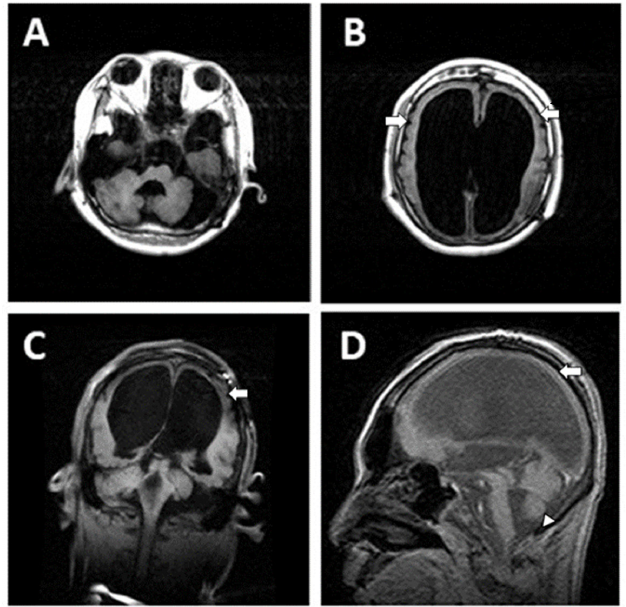
Figure 2. Brain MRI (T1WI) of Case 1 showed marked dilated ventricles with displaced cerebellum ( A ), dysgenesis of corpus callo-sum, pachy/polymicrogyria (white arrows in ( B – D )) and small vermis (arrowhead in ( D )).